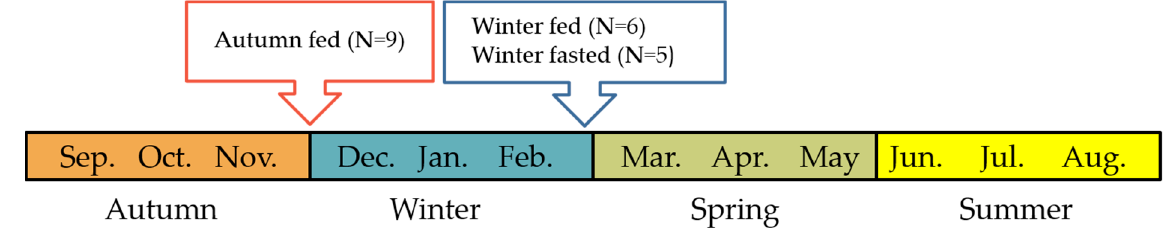
Figure 9. Timeline of the study setting and groups. The autumn fed group raccoon dogs were reared through the autumn hyperphagic phase and the experiment was finished before winter. The winter fasted raccoon dogs were fasted for ten weeks during winter while the winter fed raccoon dogs had ad libitum access to food. The experiment was finished for both of the winter groups after the